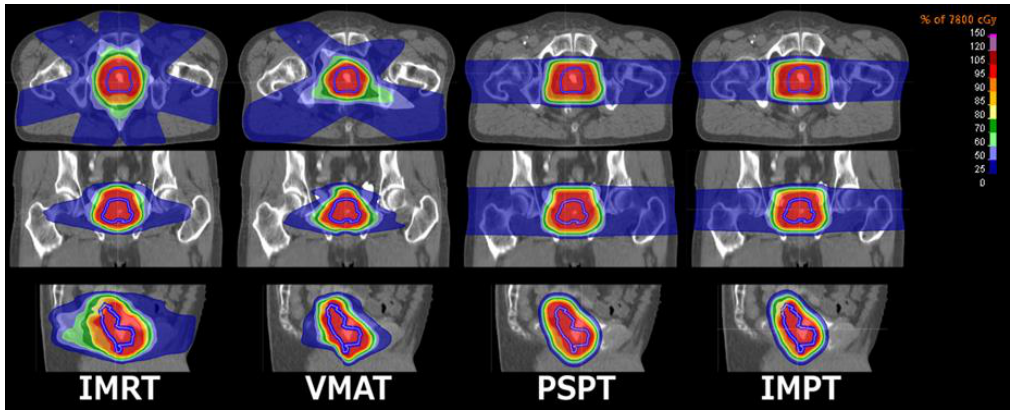
Figure 1. Dose distribution for each treatment modality: displayed in the transverse, coronal and sagittal planes. The clinical target volume is contoured in blue.